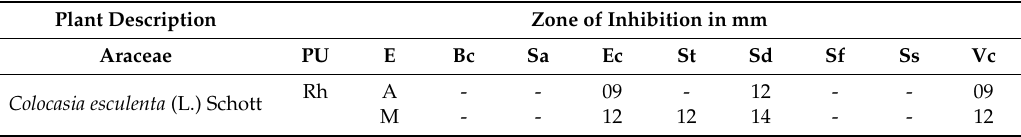
Table 2. Results of screening of plants from Northern Odisha,